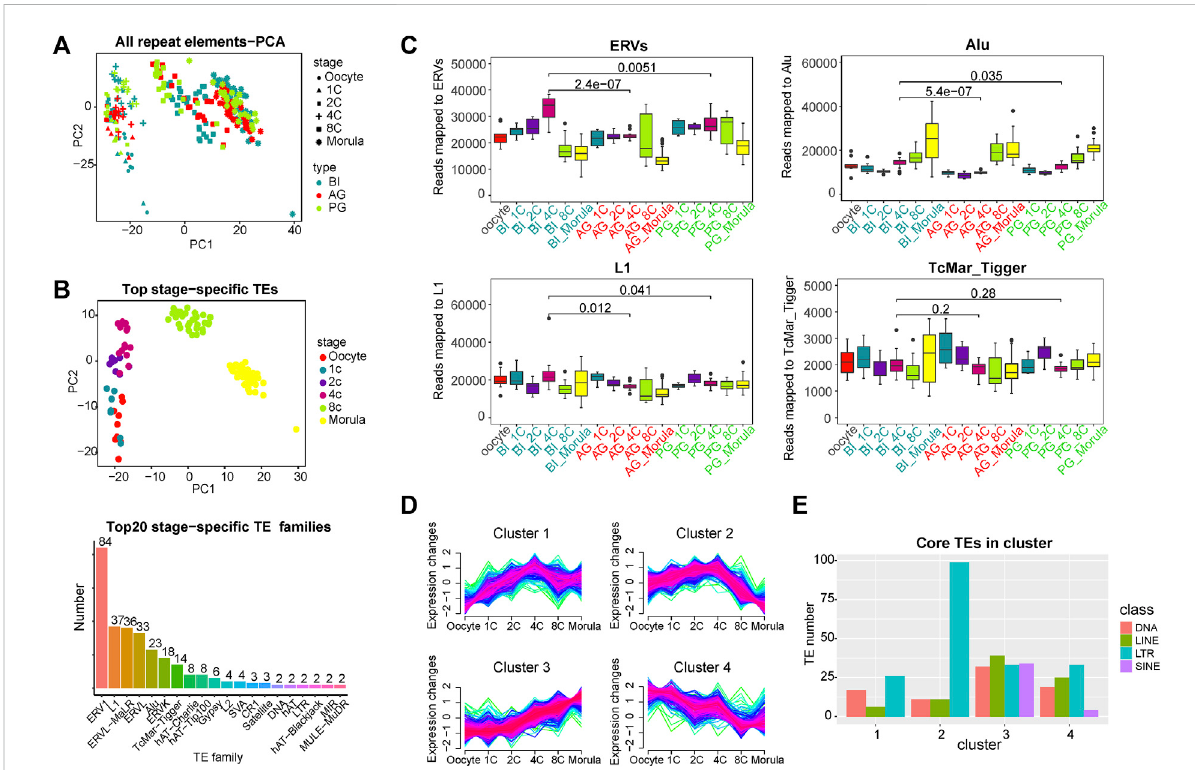
FIGURE 1 Global expression patterns of known TEs during the six consecutive stages of human preimplantation development. (A) Principal component analysis(PCA)ofallTEsofsingleblastomeresofhumanpreimplantationembryos.Blastomeresfromthesamestageofembryoareshownassymbols of the same shape. Blastomeres from the same type of embryo are shown as symbols of the same color. PCA1 and PCA2 represent the top two dimensions of the genes showing differential expression among these preimplantation blastomeres. (B) PCA on the stage-speci fi c TEs expression estimates in biparental preimplantation embryos. The 309 TEs elements that showed the highest variation between the stages were selected, select the top 60 in each stage, some of which belong to two stages. The p values are from a paired Wilcoxon test, TEs which had a p -value < 0.001 for the Wilcoxon test were selected as stage-speci fi c (above). Number of each transposon family in stage-speci fi c transposons (below). (C) Expression pro fi les of four transposon families in BI, AG, and PG embryos. ERVs include ERV1, ERVL, ERVL-MaLR, and ERVK. Y axis is the number of reads mapped to corresponding transposon families. Boxplots show the distribution for all single cells from the different developmental stages. Signi fi cance was calculated using the t test. (D) Fuzzy clustering analysis of TEs expression signals for the six consecutive stages. The closer the line color is to red, it means that these are the core TE in the cluster. (E) Number of core TE of each class in each cluster. Select transposons with membership value greater than 0.7 as core TE in ach cluster and count the number of four (membership ≥